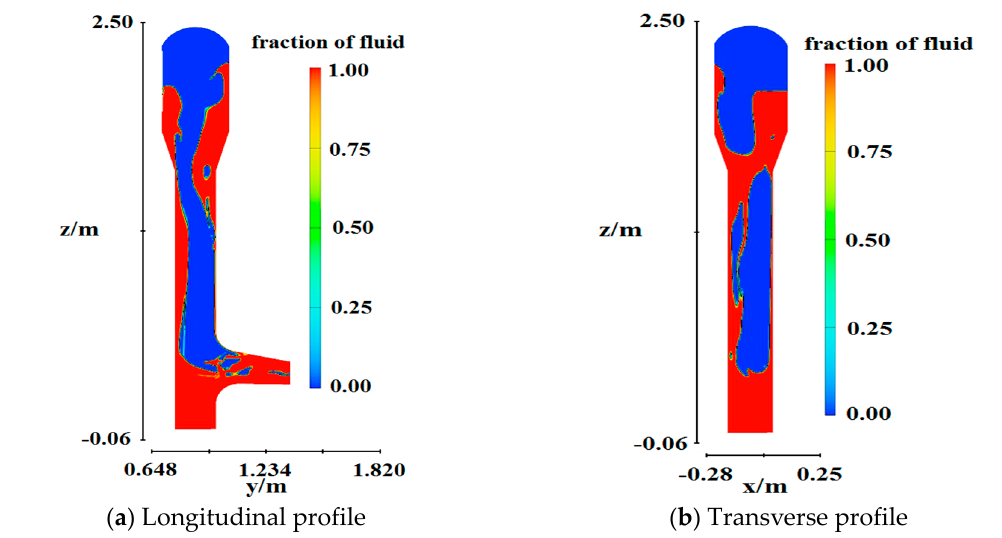
Figure 7. Volume fraction of fluid in the numerical simulation (P = 0.1%).